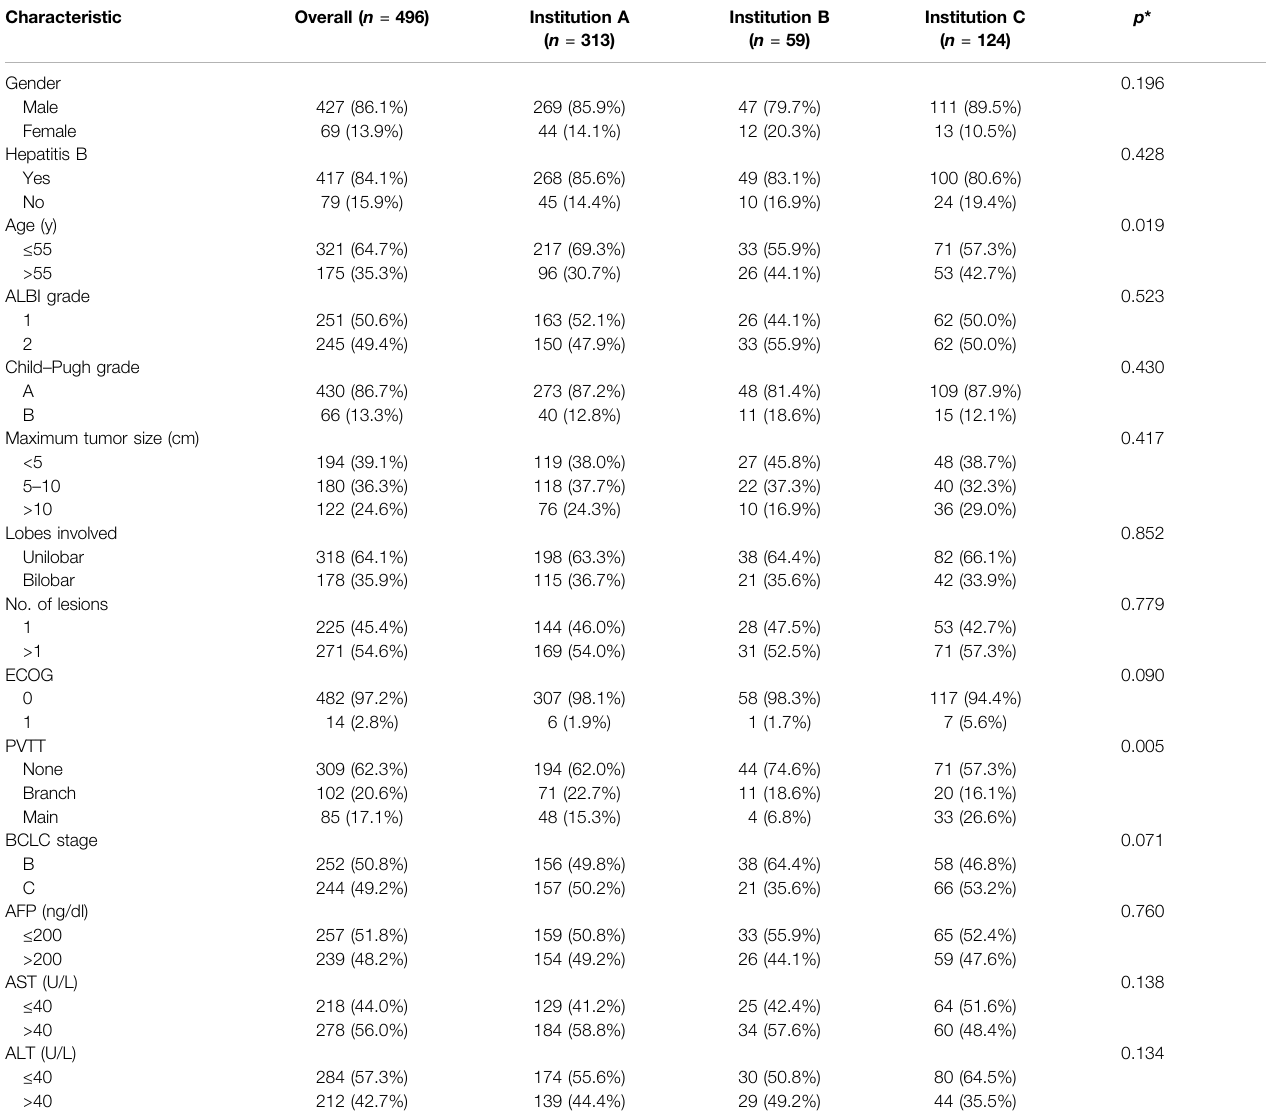
TABLE 1 | Patient